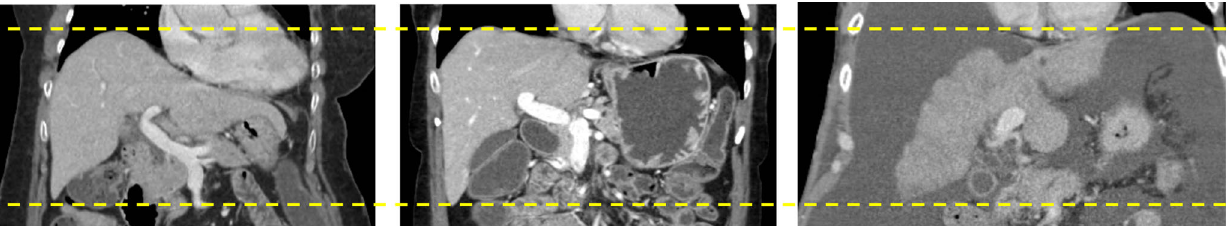
Fig. 1 Variability of liver shape and size. Livers of different shape and volume may have similar cranial-caudal length, as demonstrated with these examples of three different patients. This observation